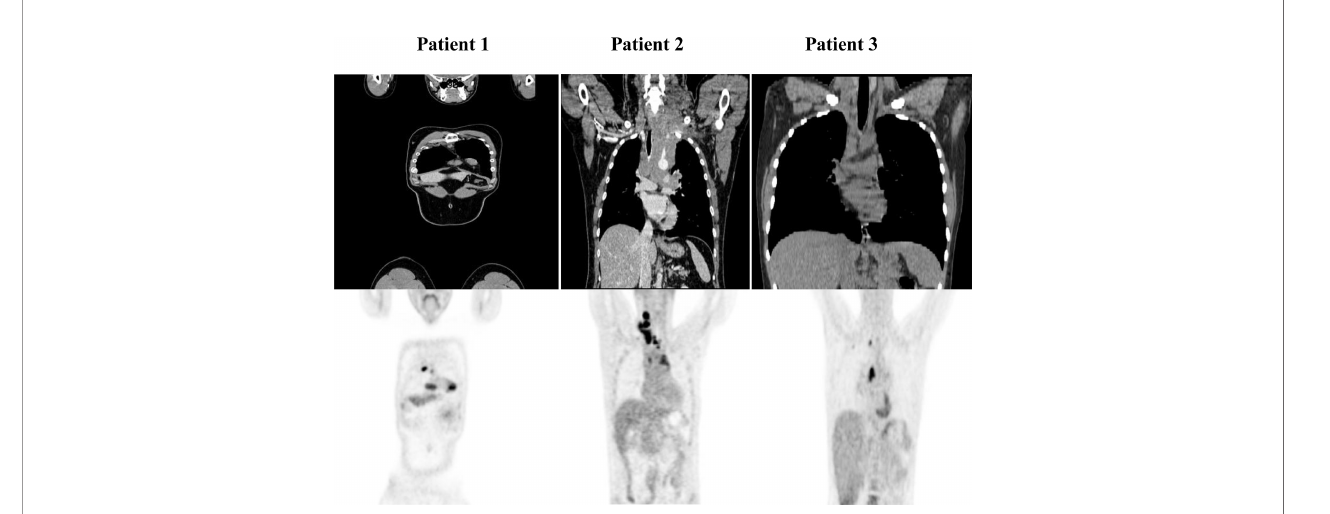
FIGURE 4 | PET/CT of r/r cHL patients prior to the initiation of anti-PD-1 treatment. Patient 1 presented with conglomerate lymph node masses at the anterosuperior mediastinum with the size of 37x21 mm, SUV 6.4 and the paragastric conglomerate with the size of 45x42 mm, SUV 7.4. Patient 2 presented with cervical lymph nodes with the size of 6.6mm, SUV 4.7 and with conglomerate lymph node mass at the anterosuperior mediastinum with the size of 74x42 mm, SUV 7.7. Patient 3 presented with conglomerate lymph node mass at the anterosuperior mediastinum with the size of 43x32 mm, SUV 8.2. SUV, standardized uptake